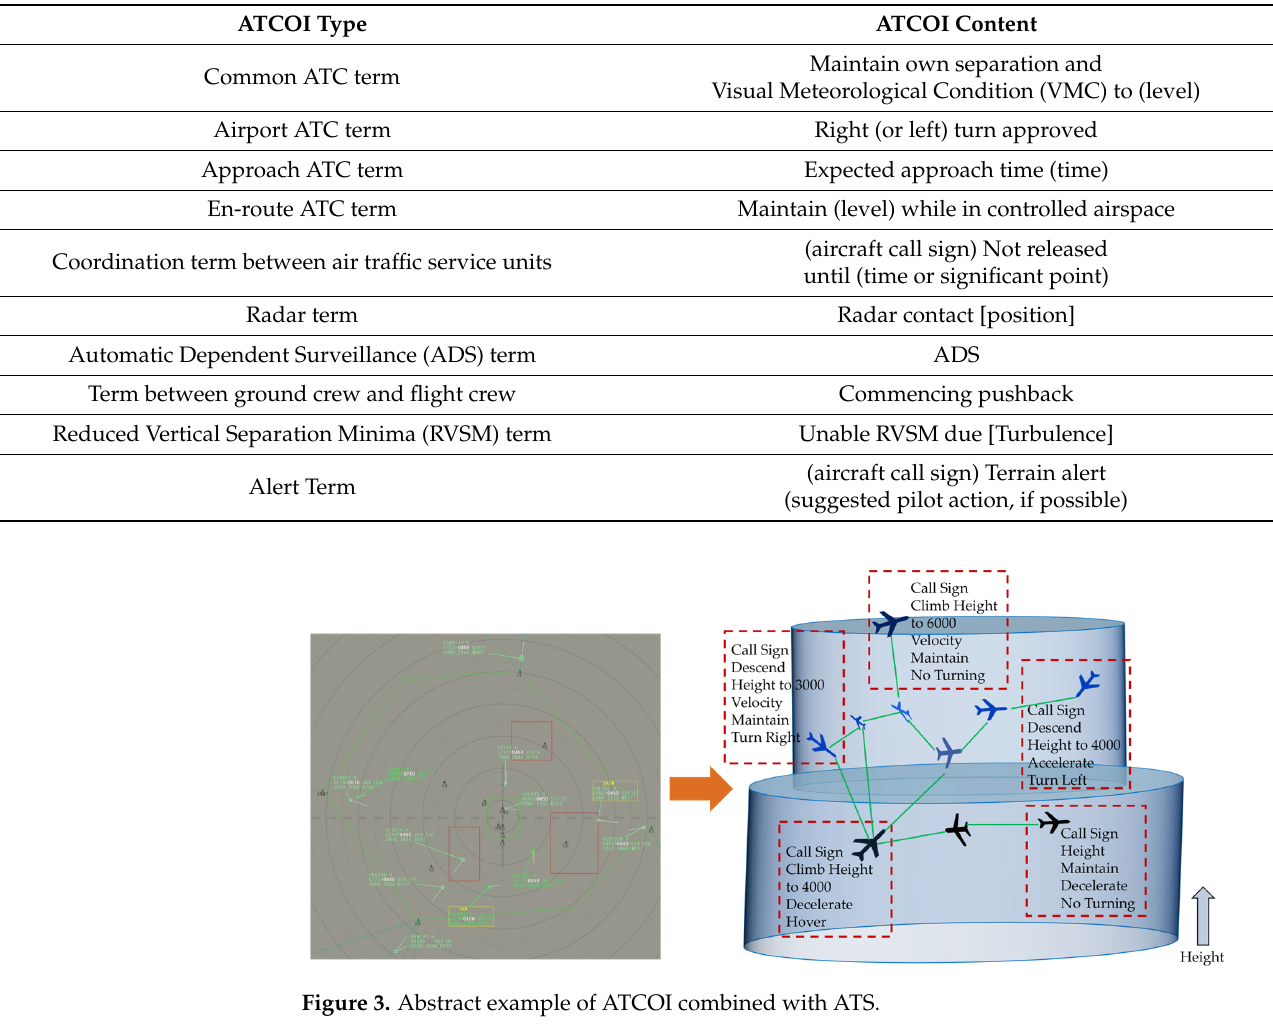
Figure 3. Abstract example of ATCOI combined with ATS.